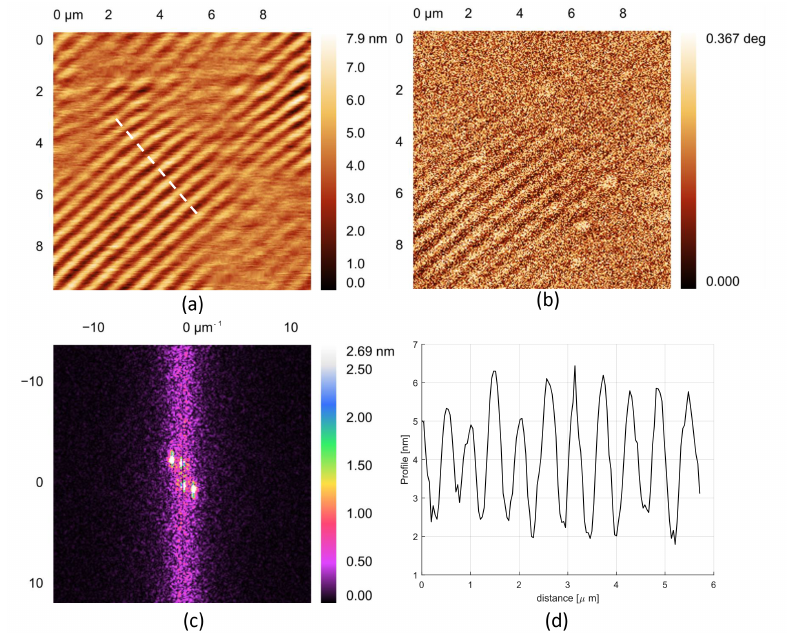
Figure 1. ( a ) Surface topography obtained by means of Atomic Force Microscopy working in non- contact mode at a resonance frequency of about 150 kHz, through a tip with radius of curvature of about 20 nm. ( b ) Phase image obtained by using the Phase Contrast Microscopy technique to highlight the surface spatial modulation of the refractive index. ( c ) Amplitude of the Fast Fourier Transform of topography. The peak positions are located at a spatial frequency corresponding to pitch of about 520 nm. ( d ) Profile taken along the dotted white line, as highlighted in